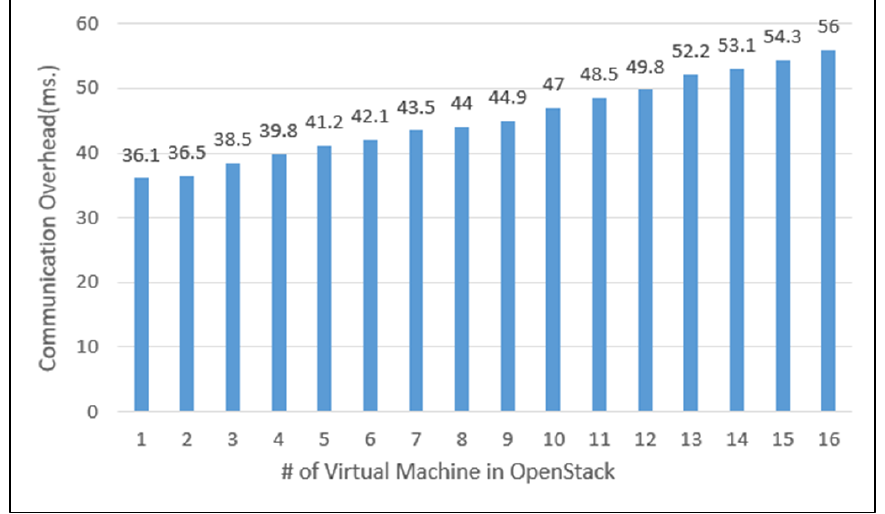
Figure 12. The communication overhead of the middleware according to the increase of VMs in Cloud .